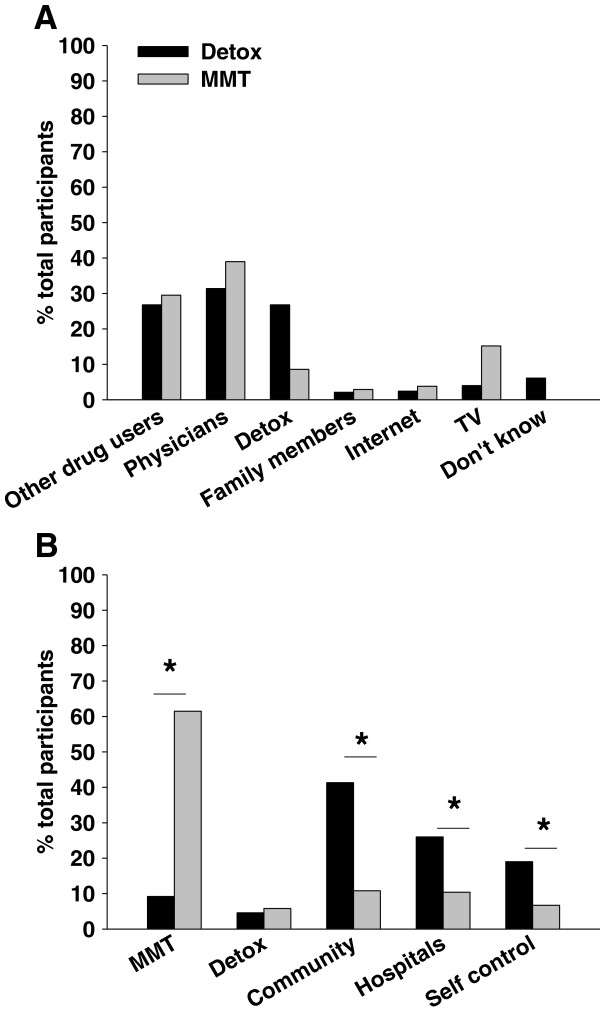
Sources of MMT information and treatment preference among participants at the Compulsory Detoxification Centre and MMT patients.(A) sources of MMT information; (B) Treatment preferences. Asterisk (*) denotes a significant difference between Compulsory Detoxification and MMT patients, p < 0.05.